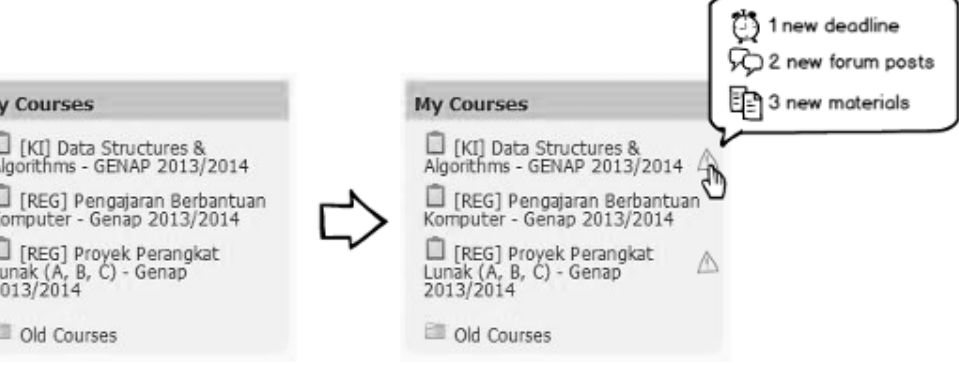
Figure 3 . Recent activities information in course